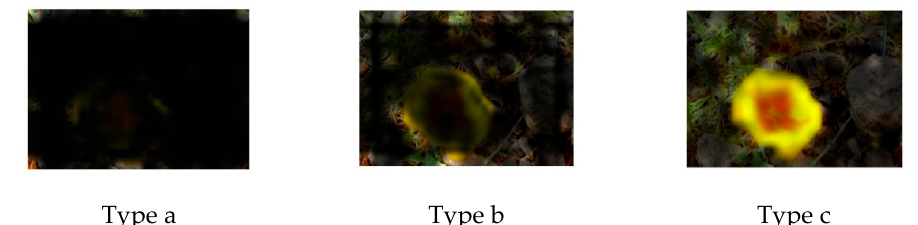
Figure 14. AIR(x, y) of Figure 12.